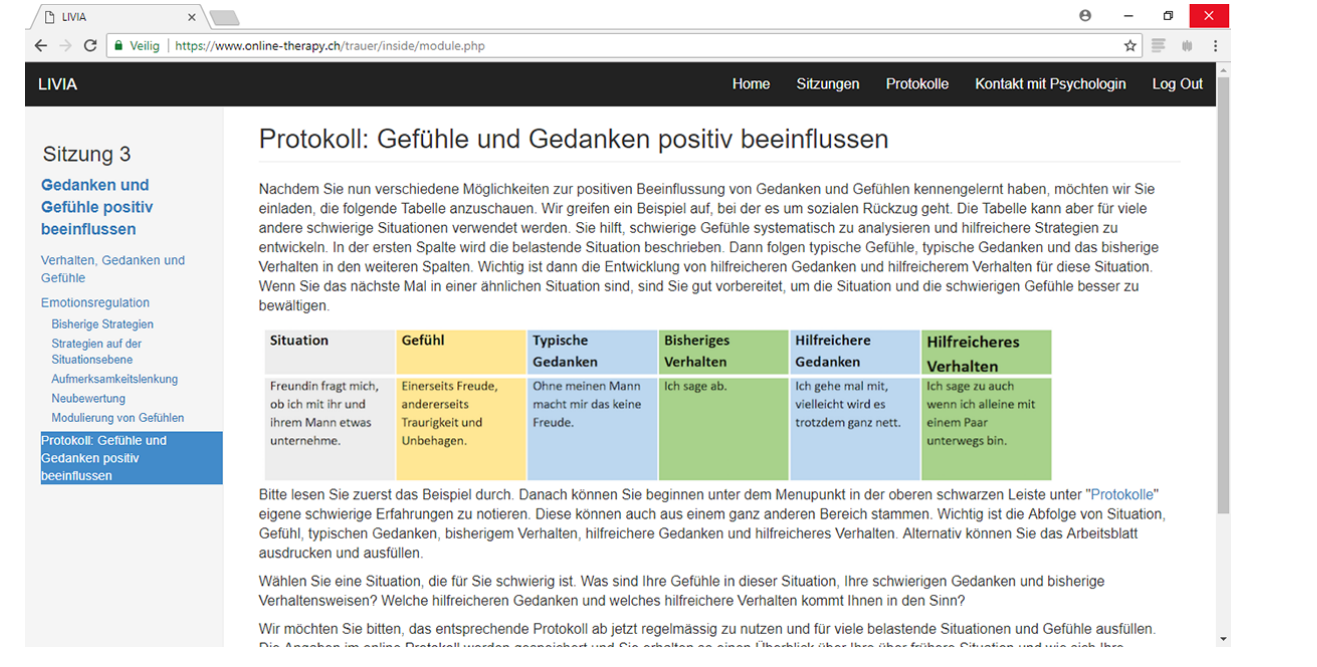
Figure 3. Online grief self-help program